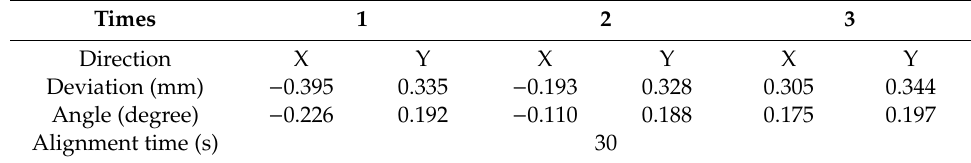
Table 1. Results of coarse alignment.